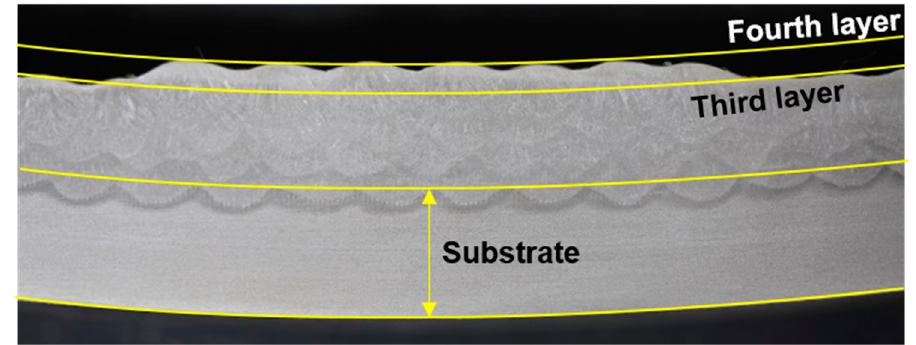
Figure 1. Cross-section of multilayer beads demonstrating thermal distortion [1].